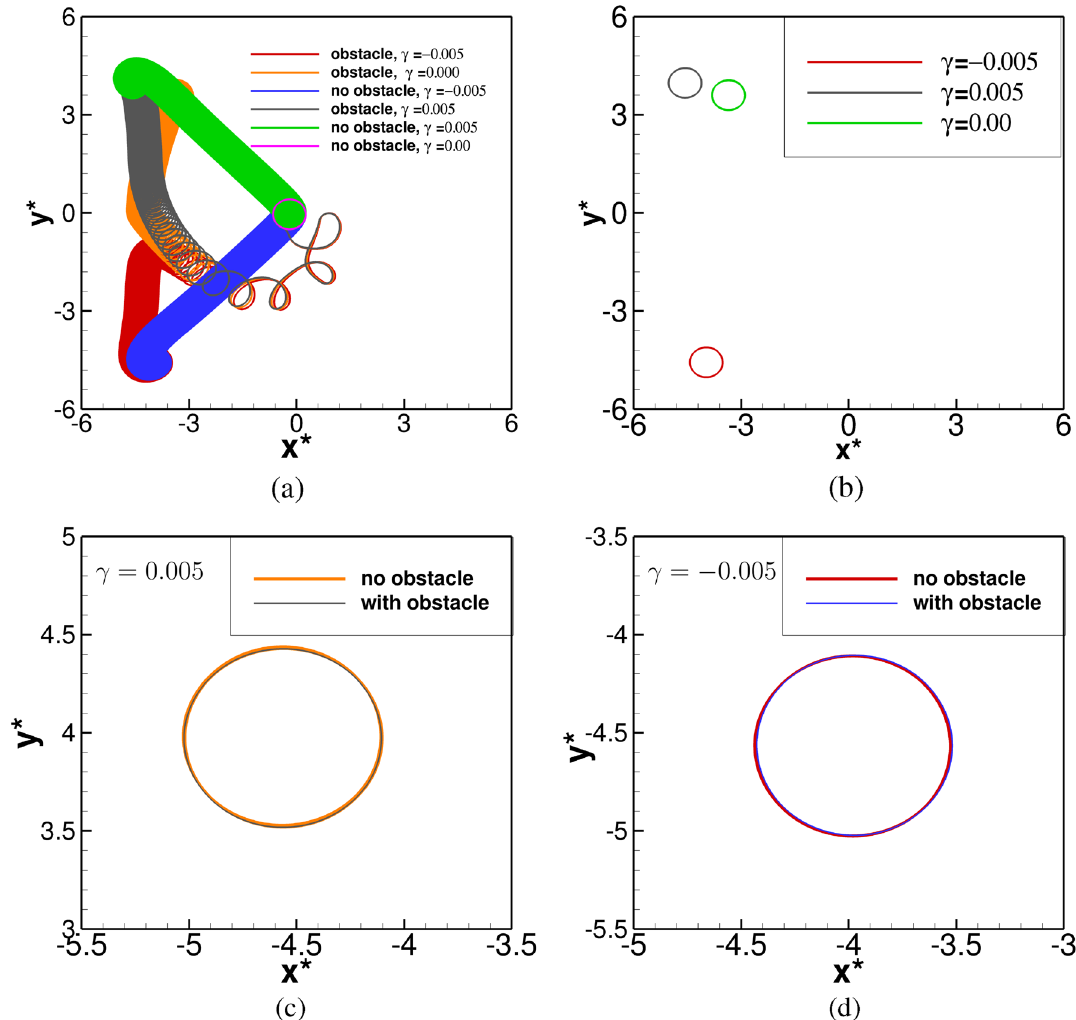
Figure 9. ( a ) Tip paths for γ = 0.000, − 0.005, 0.005 , with and without the obstacle, in 100 ≤ t ≤ 1500 , ( b ) tip paths for γ = 0.000, − 0.005, 0.005 with obstacle in 1100 ≤ t ≤ 1200 , ( c, d ) tip paths with and without the obstacle in 1100 ≤ t ≤ 1200 , for γ = 0.005 and − 0.005 respectively.